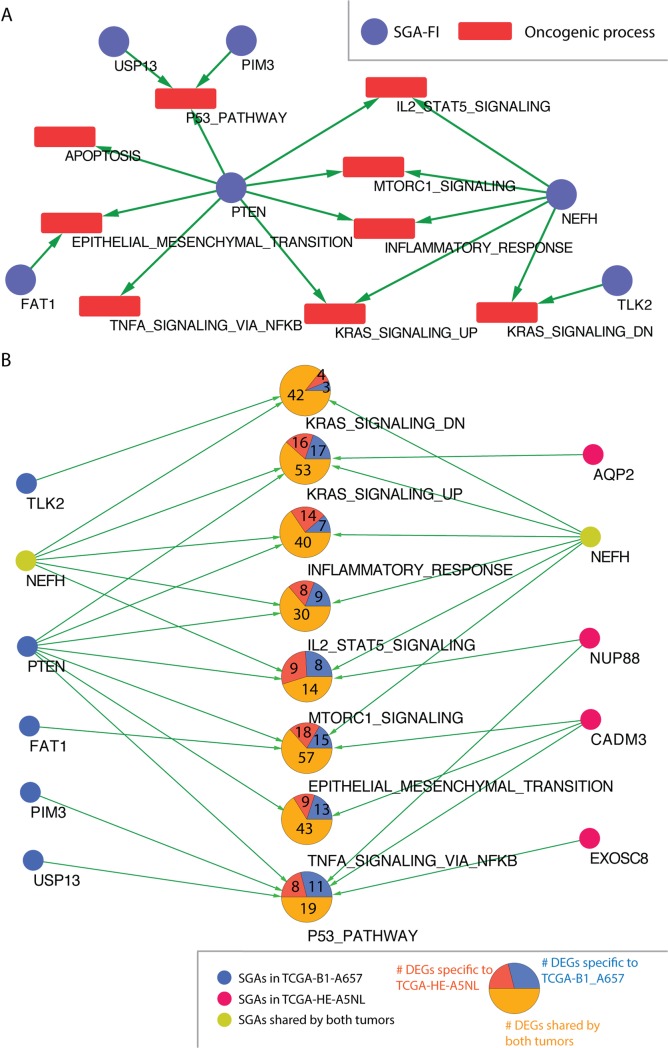
TCI predicts the SGA-FIs and their functional impact at the individual tumor level.A. A graph produced by TCI for tumor TCGA-B1-A657 that predicts major SGA-FIs and their regulated cancer processes. Blue nodes represent SGA-FIs and red nodes (squares) represent oncogenic processes. An green directed link indicates that TCI predicts that the SGA-FI at the tail of tha arrow regulates 10% or more of the DEGs in the cancer process at the head of the arrow. B. Same DEGs regulated by distinct SGA-FIs in different tumors. DEGs in cancer processes shared between tumor TCGA-B1-A657 and tumor TCGA- HE-A5NL are shown as pie-charts. Blue nodes denote SGA-FIs in tumor TCGA-B1-A657. Red nodes denote SGA-FIs in tumor TCGA- HE-A5NL. Yellow nodes, (i.e., NEFH), are shared by both tumors. Each large node in the middle represents an oncogenic process. Within the circular nodes in the middle of the figure, the number in the purple area denotes the number of DEGs specific to TCGA-B1-A657. The number in the red area denotes the number of DEGs specific to TCGA- HE-A5NL. The number in the yellow area denotes the number of DEGs shared by both tumors. An green directed link indicates an SGA-FI regulates 10% or more DEGs in the cancer process.